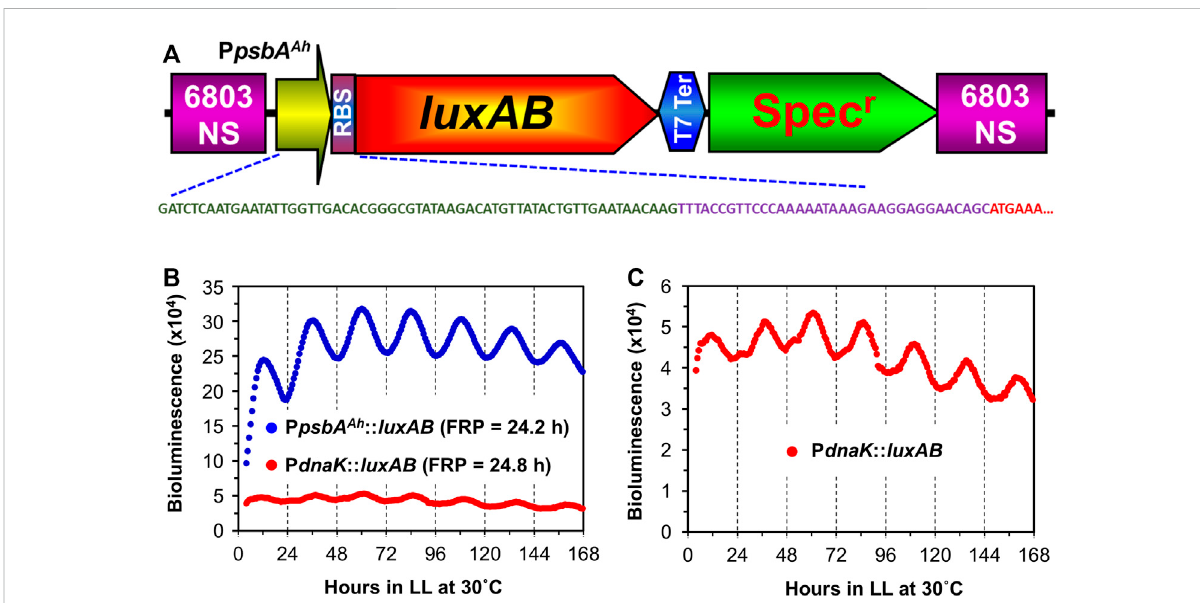
FIGURE 1 Comparison of rhythmic luxAB expression between the plant psbA promoter and the native dnaK promoter from colonies of Synechocystis sp. PCC 6803 on agar. (A) . Diagram of the P psbA Ah ::luxAB expression construct with a spectinomycin resistance marker inserted into the genome of PCC 6803. The DNA sequence shows the nucleotide sequences of the psbA promoter from the chloroplast of Amaranthus hybridus (green), an arti fi cialribosomalbindingsite(purple),andthepartialN-terminalcodingregionof luxA (red).Thephysicalmapandfullnucleotidesequenceof the P psbA Ah ::luxAB expression plasmid is presented in Supplementary Figure S1. (B) . Representative luminescence rhythms and calculated free- running periods (FRPs) of the P psbA Ah ::luxAB and P dnaK ::luxAB reporters monitored in constant light at 30 ° C with the Kondotron. (C) . The same luminescence rhythm for the P dnaK ::luxAB reporter shown in panel B but on an expanded